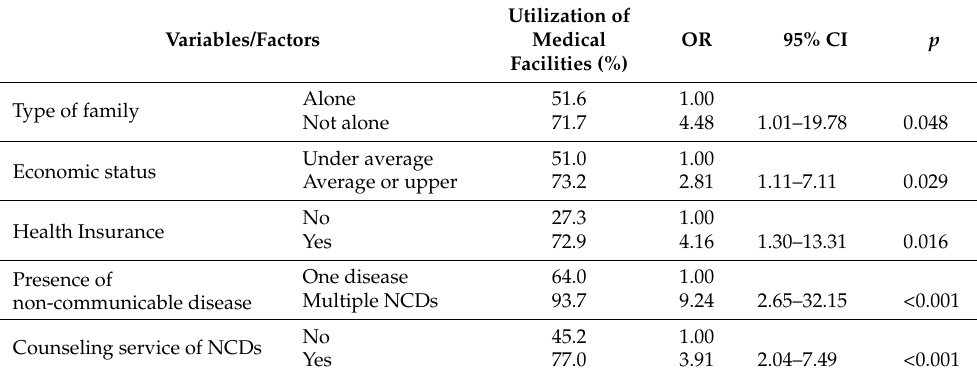
Table 3. Multiple logistic regression analysis of associated factors and health-seeking behavior for utilized medical facilities (n =